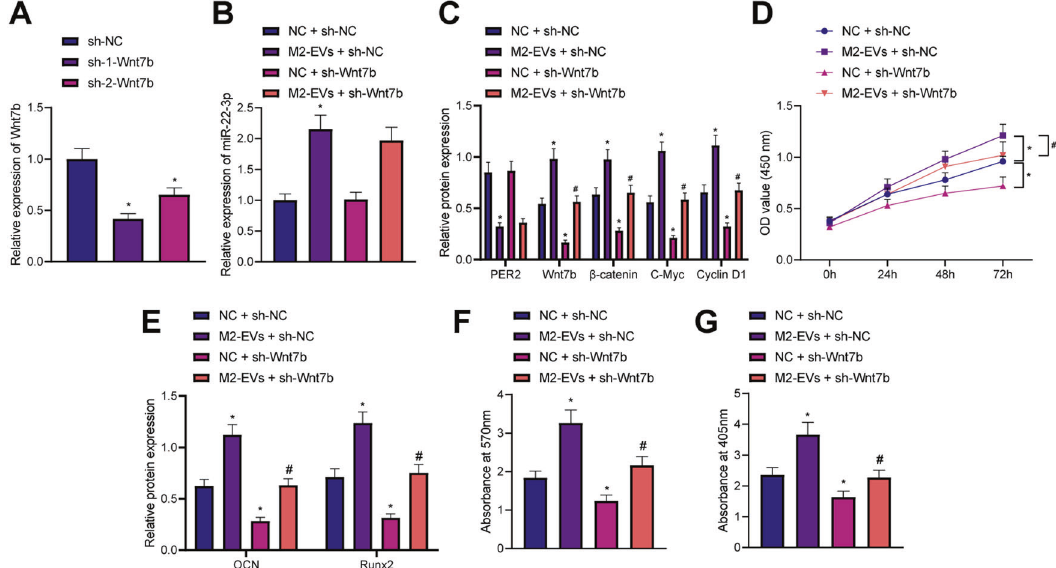
Fig. 6 miR-22-3p shuttled by M2-EVs promoted the osteogenic differentiation of AS-BMSCs via the PER2/Wnt/ β -catenin signaling. A Wnt7b mRNA expression in AS-BMSCs transfected with sh-1-Wnt7b or sh-2-Wnt7b determined by RT-qPCR. B miR-22-3p expression in AS- BMSCs treated with M2-EVs (100 µg/mL) and/or sh-Wnt7b measured by RT-qPCR. C The protein expression of PER2, Wnt7b, and Wnt/ β -catenin signaling pathway-related proteins ( β -catenin, C-Myc, and Cyclin D1) in AS-BMSCs treated with M2-EVs (100 µg/mL) and/or sh-Wnt7b measured by Western blot analysis. D The viability of AS-BMSCs treated with M2-EVs (100 µg/mL) and/or sh-Wnt7b detected by CCK-8 assay. E Expression of Runx2 and OCN in AS-BMSCs treated with M2-EVs (100 µg/mL) and/or sh-Wnt7b measured by Western blot analysis. F Mineralization of AS-MSCs treated with M2-EVs (100 µg/mL) and/or sh-Wnt7b detected using Alizarin red staining. G ALP content of AS- BMSCs treated with M2-EVs (100 µg/mL) and/or sh-Wnt7b detected by ALP staining. * p < 0.05, vs. AS-BMSCs treated with sh-NC/NC + sh-NC, # p < 0.05 vs. AS-BMSCs treated with M2-EVs + sh-NC. The cell experiment was repeated three times